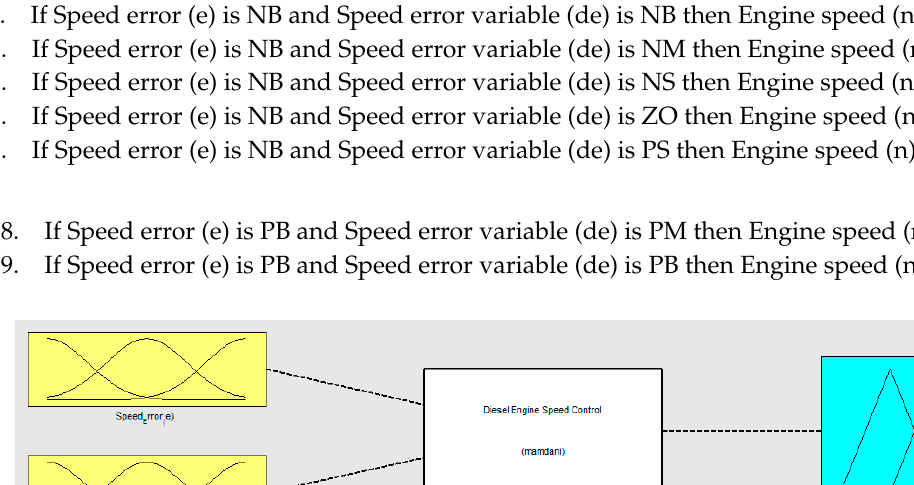
Table 1. Control rules of diesel engine speed by fuzzy logic control.